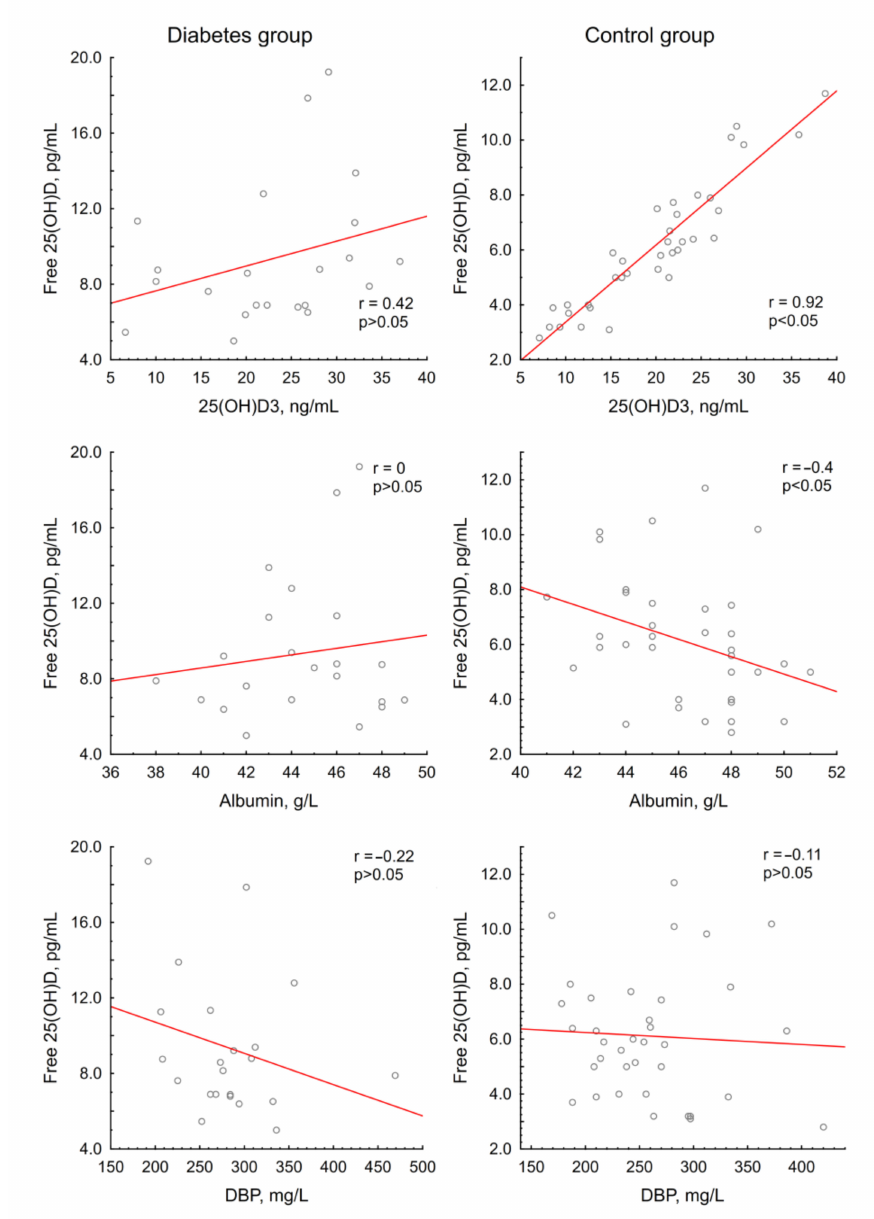
Figure 2. Interrelation of free 25(OH)D and 25(OH)D 3 , transport proteins in